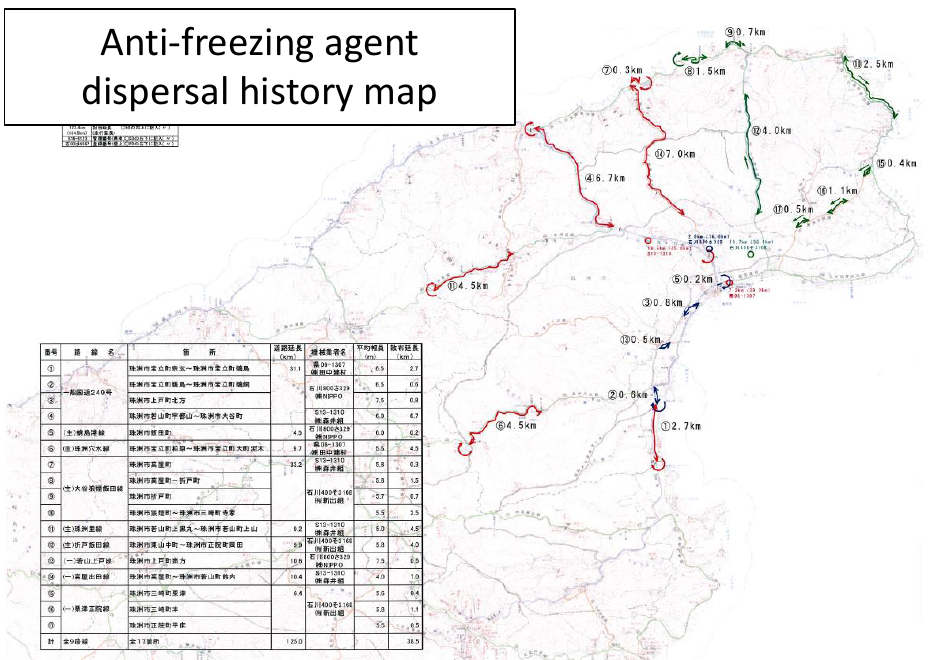
Figure 1. Historical map of anti-freezing agent dispersal.